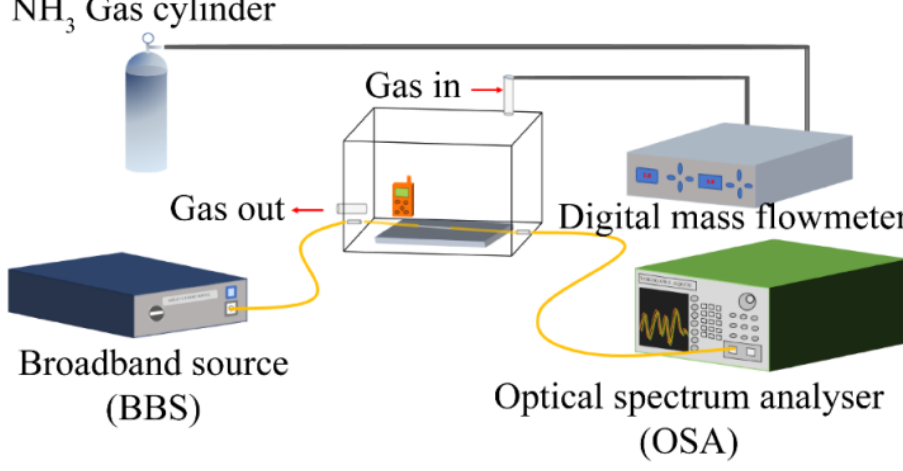
Figure 8. Schematic of gas sensing measurement system.